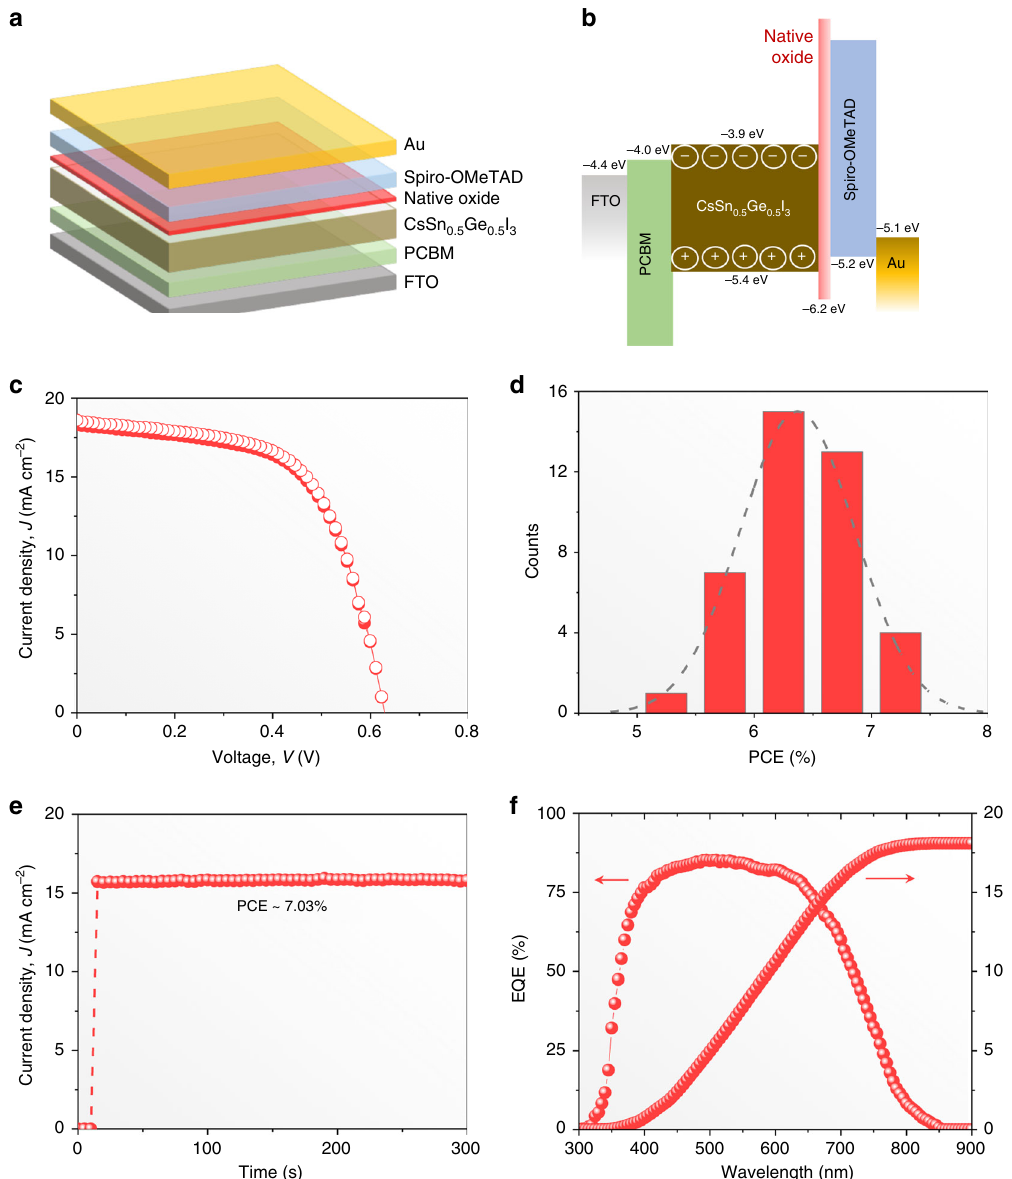
Fig. 4 Device architecture and performance of CsSn 0.5 Ge 0.5 I 3 thin- fi lm PSCs. a Schematic illustration showing the planar PSC device structure used here. b Corresponding energy-level diagram. c J – V responses of the “ champion ” PSC device. d PCE statistics. e Stabilized power output and f EQE spectrum of the “ champion ” PSC